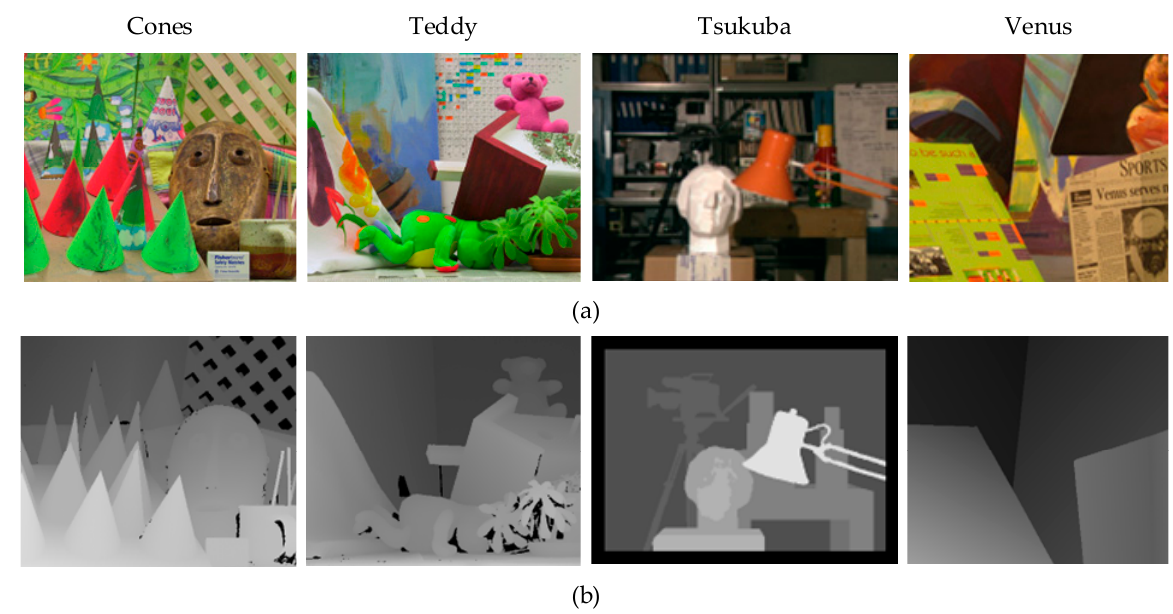
Figure 5. Middlebury stereo evaluation datasets. ( a ) Left images of the stereo pairs from four datasets: Cones, Teddy, Tsukuba and Venus. ( b ) Ground truth maps of these images. Table 1. Parameter settings of